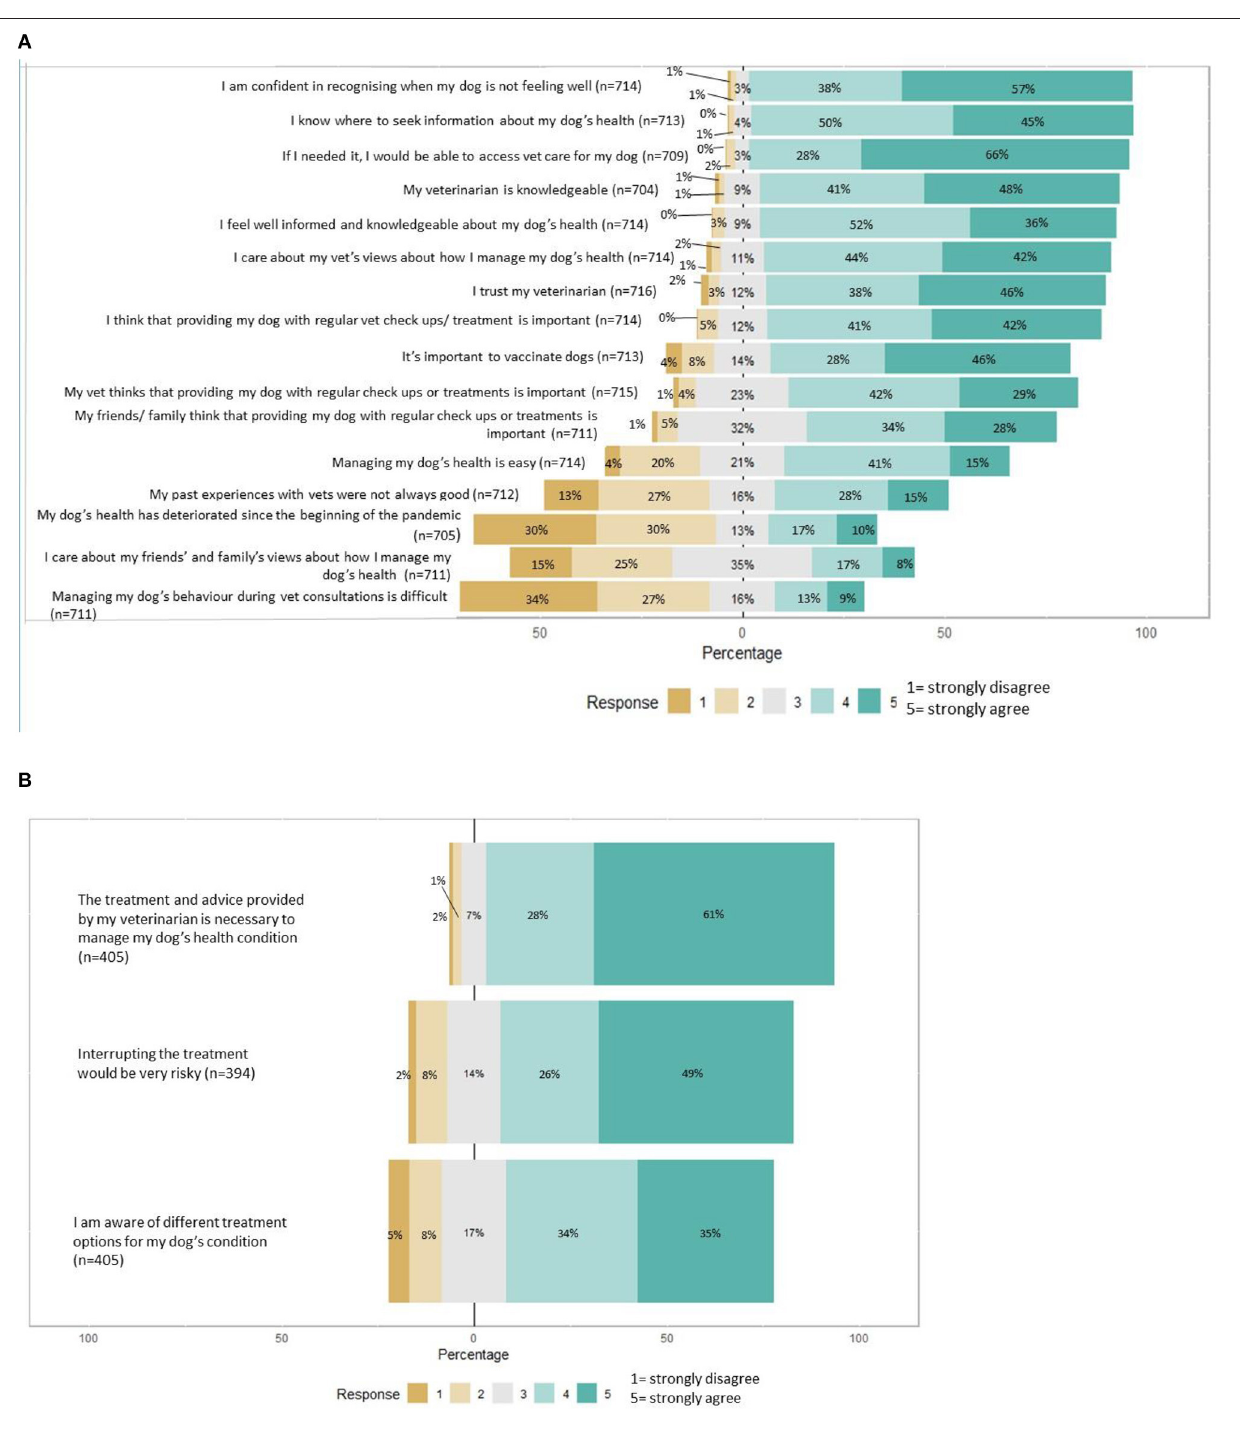
and (3) urgency to seek care (analysis of the subset of dogs with a chronic condition, as respondents who confirmed a chronic condition diagnosis were asked additional questions that